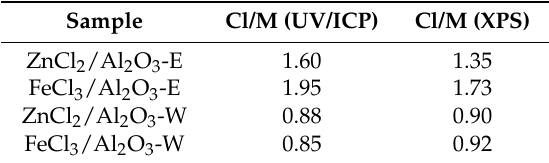
Table 3. The ratio of Cl/Zn in the prepared catalysts determined by UV, ICP and XPS.